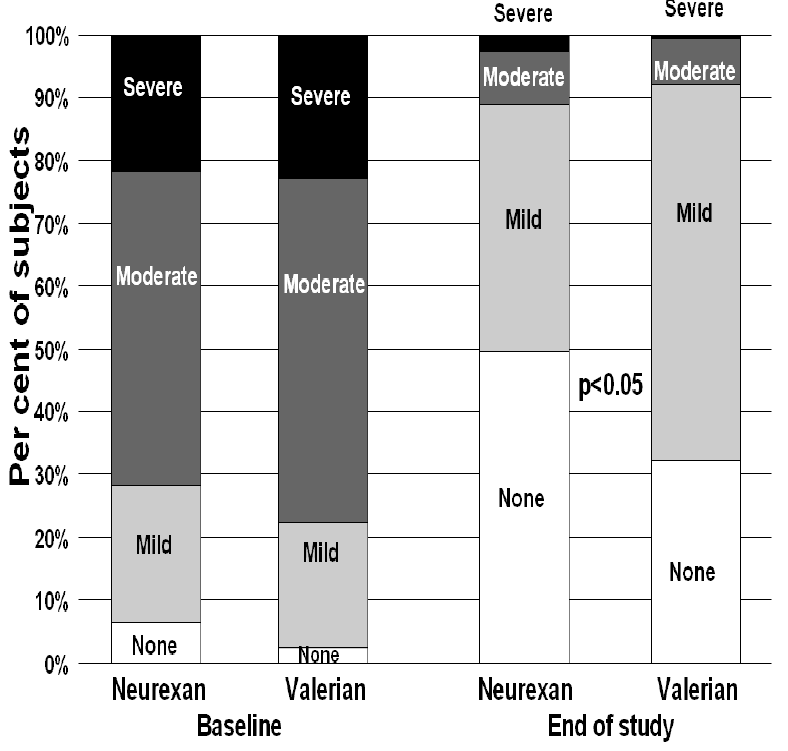
FIGURE 3. Daytime fatigue at baseline and end of study. The reduced amount of fatigue in the Neurexan group (n = 153) as compared to the valerian group (n = 164) at the end of the treatment period was statistically